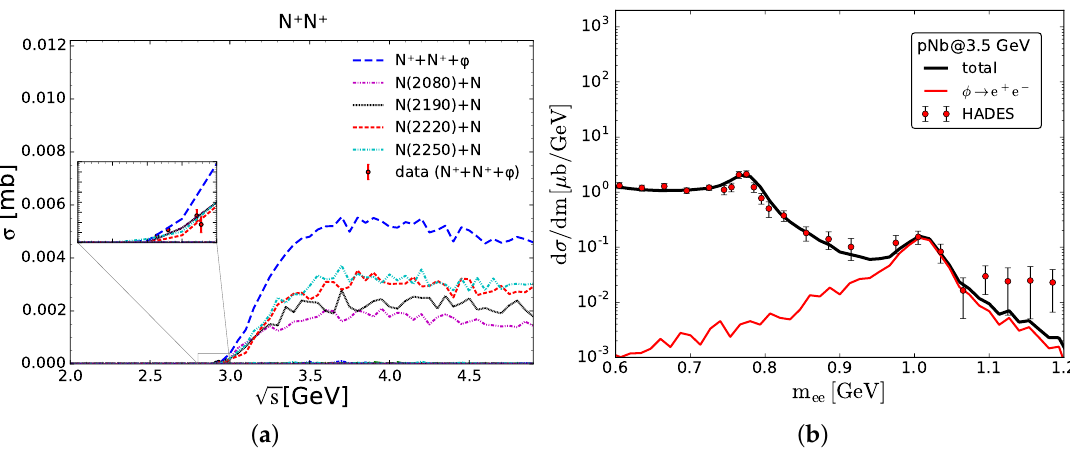
Figure 2. ( a ) pp → pp φ cross section reconstructed from SMASH output (lines) compared to experimental data [13,14] (circles). ( b ) Dielectron mass spectrum in proton-niobium collisions at E kin = 3.5GeV in SMASH (lines) compared to HADES data (circles). Unlike the elementary cross section, the pNb dilepton spectrum constrains the φ